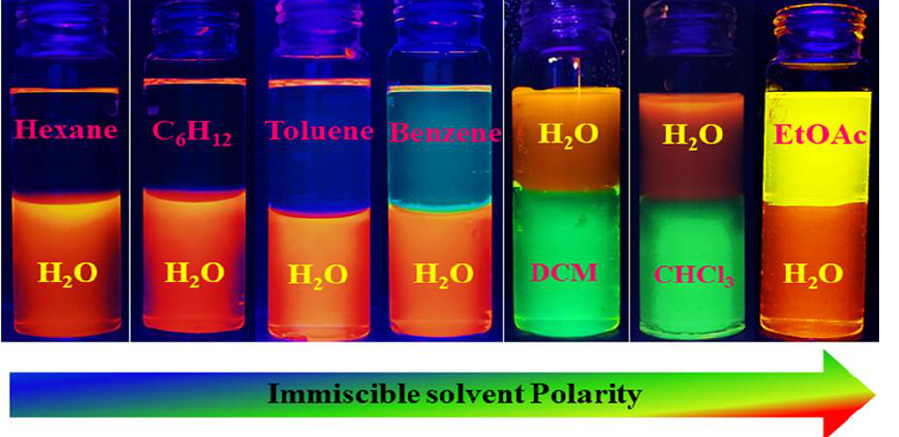
Figure 14. Two-color fluorescent layers of CDs in different immiscible solvents. (Reprinted from [122]; with the permission of the American Chemical Society).